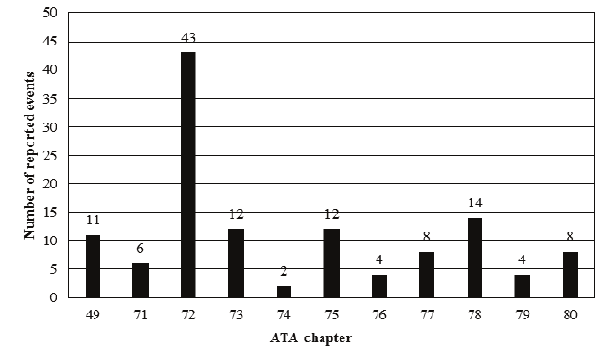
Fig. 26. Number of the turbojet engine system events coded by ATA 100 chapter between 2008 and 2016